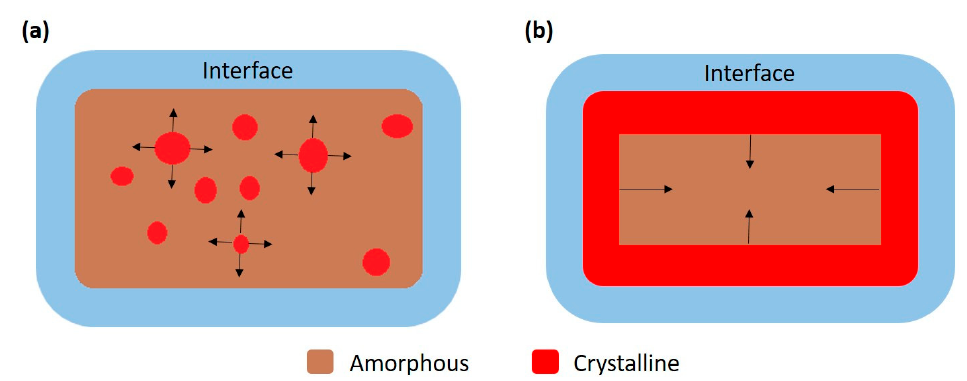
Figure 5. Two different kinetics of crystallization: ( a ) nucleation-dominated crystallization kinetics where there is a random distribution of islands of crystallinity that later expand; ( b ) growth- dominated crystallization where the initial crystalline precipitate grows to include the rest of the amorphous material.